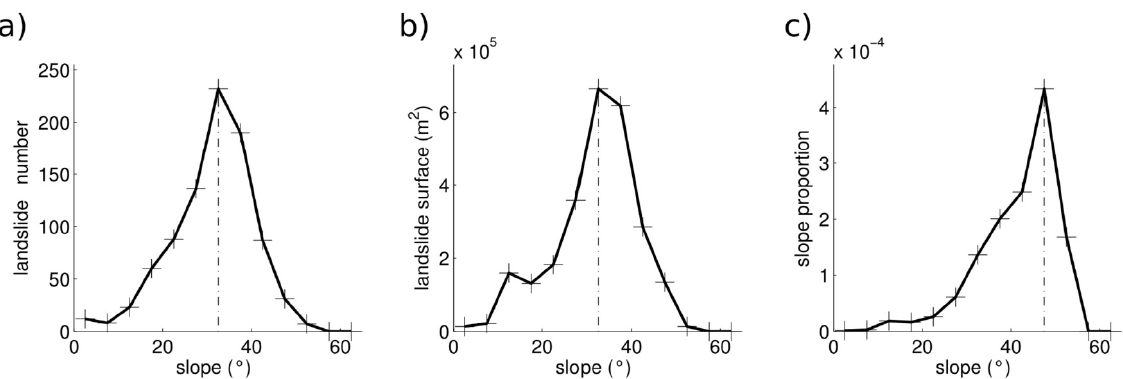
Figure 12. ( a ) Distribution of landslide numbers as a function of slopes; ( b ) Distribution of landslide area as a function of slopes; ( c ) Proportion of slopes affected by landslide, i.e. , the percentage of area of each slopes covered by